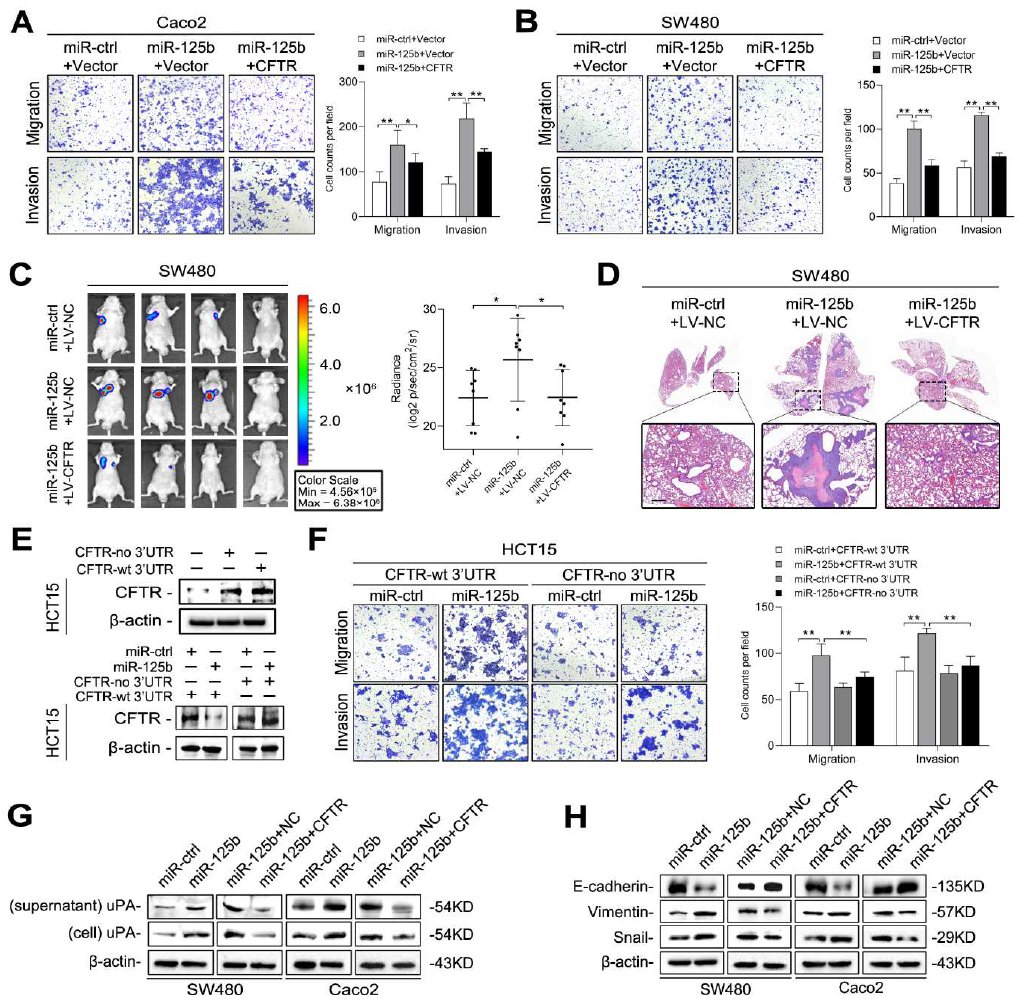
Figure 6. miR-125b induces epithelial-mesenchymal transition (EMT) and urokinase plasminogen activator (uPA) secretion by targeting CFTR. ( A , B ) Transwell assays of Caco2 ( A ) and SW480 ( B ) cells cotransfected with miR-125b or miR-ctrl and the CFTR plasmid or control vector. ( C ) Bioluminescent images and radiance values of mice ( n = 8) injected with SW480 cells after the indicated transduction. ( D ) Representative H&E staining images of lung tissue sections from the indicated groups. Scale bars represent 500 μm. ( E ) CFTR plasmid containing either with or without 3′ UTR was transfected into HCT15 cells, and western blotting was performed 48 h after transfection (upper). HCT15 cells were transfected with CFTR plasmid containing wild-type 3′ UTR or lacking 3′ UTR along with miR-125b or vector control (lower). ( F ) Migration and invasion assays of HCT15 cells transfected with the CFTR expression plasmid with or without 3′ UTR along with miR-125b or miR-ctrl. ( G ) Western blotting analysis of uPA in the indicated cells. ( H ) Western blotting analysis of EMT markers in the indicated cells. * p < 0.05, ** p < 0.01 by one-way ANOVA followed by Dunnett’s multiple comparison.